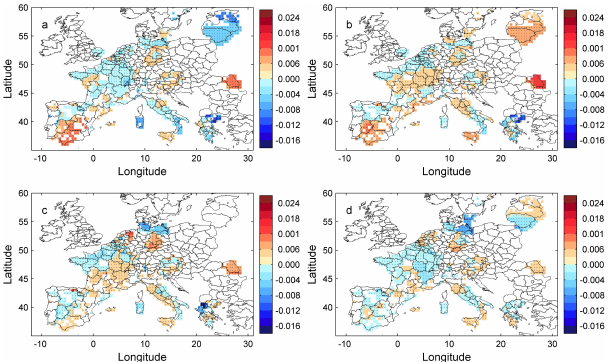
Figure 5. Spatial patterns of the trends in crop yield interannual variability. The estimated trends in the moving CVs of the detrended crop yield calculated using a 10yr sliding window with 1yr lag dur- ing the 1975–2009 period for barley (a) , wheat (b) , grain maize (c) and potatoes (d) . The trends in time series are estimated by the Theil–Sen slope method (Yue et al., 2002). Significant trends were marked by black points. Blank region indicates that there is inten- sive irrigation (with irrigated area fraction ≥ 15%), no crop yield records or a very low ( < 5%) fraction of cropland in those pixels.